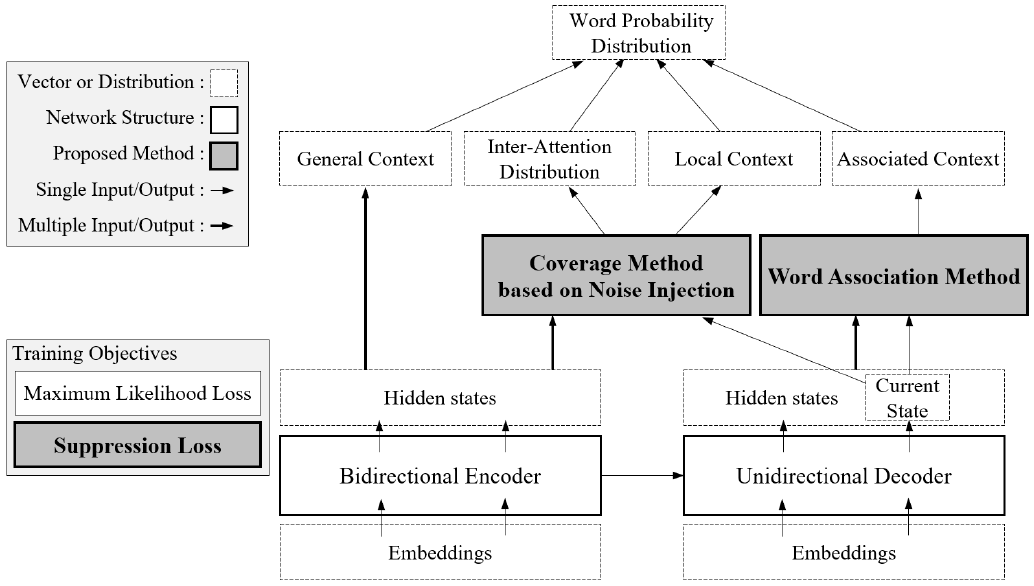
Figure 1. Structure of the proposed model.